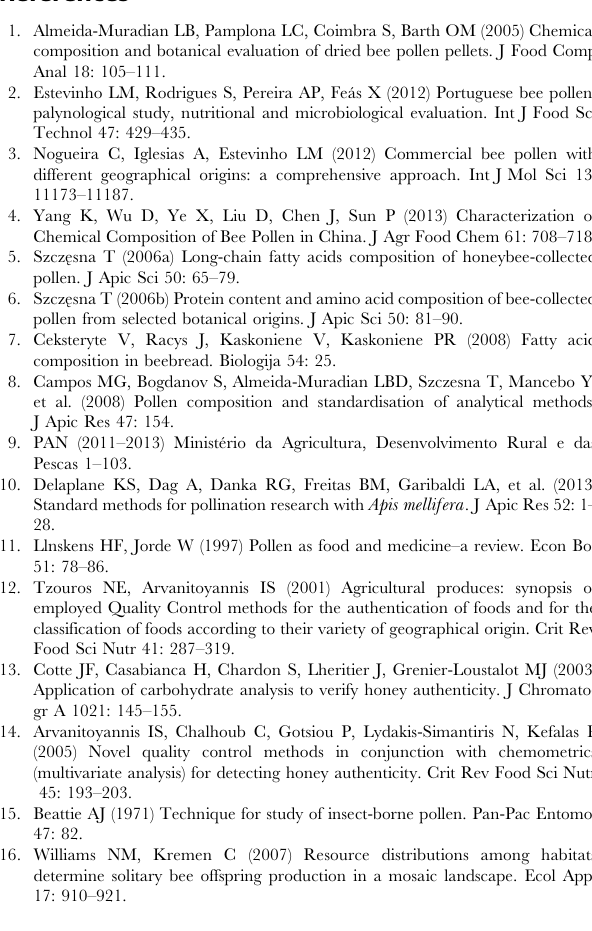
Figure S2 Accumulation curves. Diversity of rbcL and trnH- psbA DNA barcoding sequences detected in pollen pellets from three sampling sites, in relation to number of clones sequenced. The rarefaction curves for sampling sites showed that almost all of these clearly reached the asymptote, which means that the amount of clones sequenced per locality was high enough to detect the great majority of pollen species sequences in it. Table S1 Reference database of plant species for the Grigna Settentrionale Regional Park. For each species included in the list, the provenance of the sample (Genbank or the voucher name of the sample analyzed in this study), the species status in the study area and Genbank accession numbers for both rbcL and trnH-psbA are provided. *= sequence retrieved from